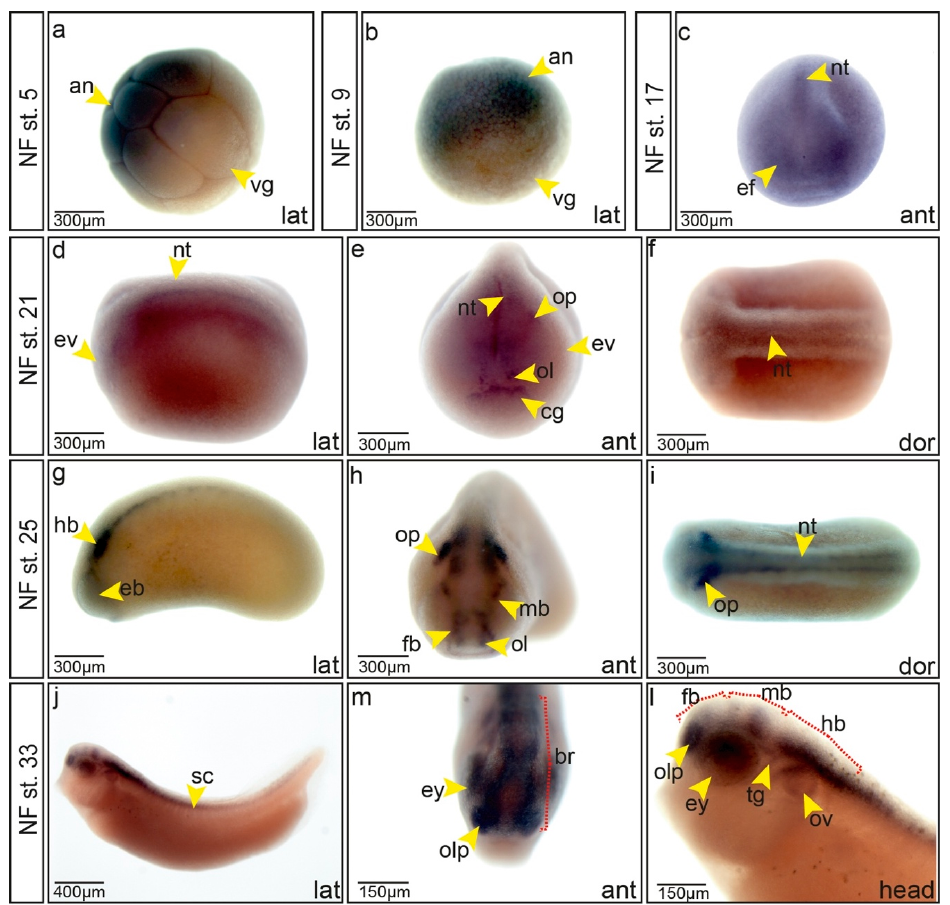
Figure 1. Expression of trim2 during neurogenesis. ( a – i ) trim2 expression was assessed by whole-mount in situ hybridization (Wmish) at different developmental stages. ( a – b ) Maternal trim2 transcripts were detected in the animal (an) opposed to the vegetal (vg) hemisphere of Xenopus embryos. ( c ) NF stage 17, anterior view, trim2 transcripts were evident in the eye field (ef) and in the forming neural tube (nt). ( d – f ) NF stage 21, lateral, anterior and dorsal views. trim2 transcripts were detected in eye vesicle (ev), neural tube (nt), olfactory (ol), and otic placode (op), as well as cement gland anlage (cg). ( g – i ) At NF stage 25, trim2 expression became more distinct in eye vesicle (eb), forebrain (fb), midbrain (mb), olfactory placode (ol), otic placode (op), and neural tube (nt). (j–l) NF stage 33, trim2 in fore- (fb), mid- (mb), and hindbrain (hb), eye (ey), olfactory pit (olp), otic vesicle (ov), spinal cord (sc), and trigeminal ganglion (tg). Scales as indicated. ( strd -mo n = 20 embryos; trim2 -mo n = 16 embryos (E); p = 1.97E-09, unpaired χ 2 test, χ 2 = 36, df =1, phenotype occurrence (po) =16, p < 0.001).